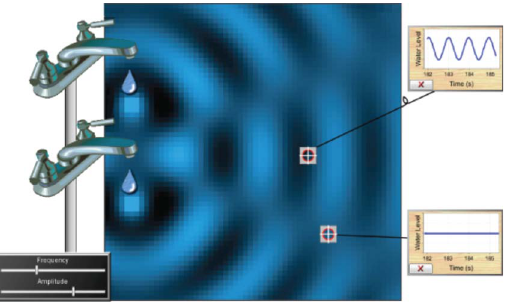
FIG. 5. (cid:1) Color (cid:2) Two source interference of water waves. Fuzzy lines represent nodal lines where wave amplitude is zero. Detectors are placed in an area of large wave activity and on a nodal line, resulting in a large amplitude curve and a flat line on the detector